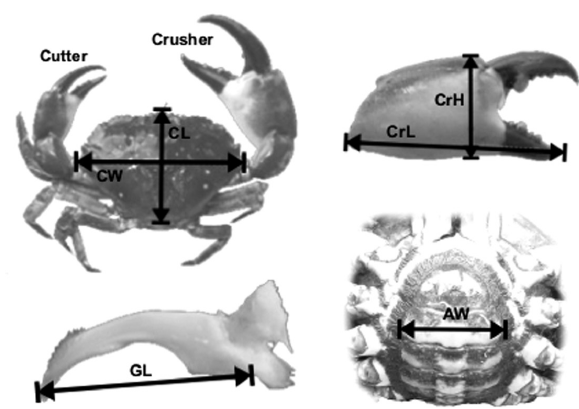
Fig. 2. – Body dimensions of Platyxanthus crenulatus measured for morphometric analysis. CW, carapace width; CL, carapace length; CrL, length of the propodus of the crusher; CrH, height of the pro- podus of the crusher; AW, maximum width of the sixth abdominal segment of females; GL, gonopod